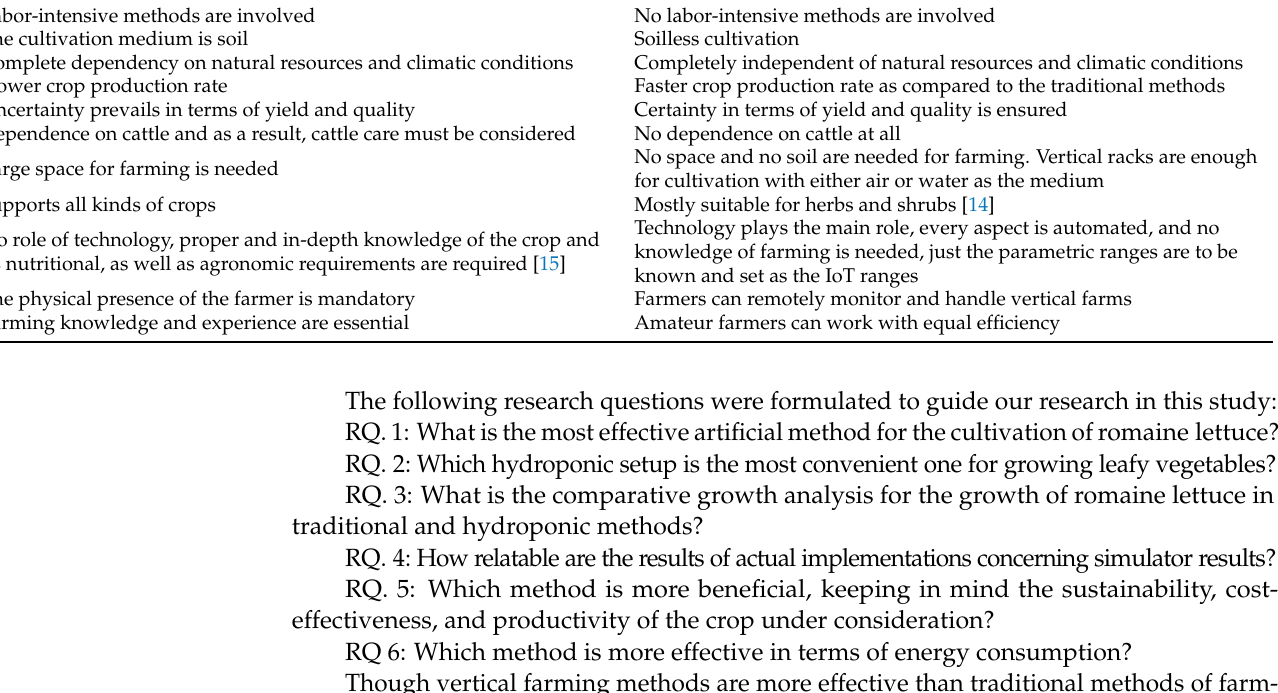
Table 1. Substrate farming vs. vertical